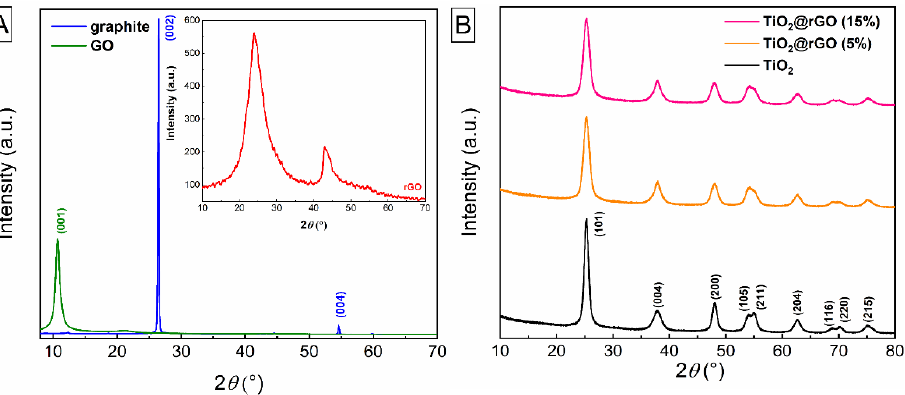
Figure 3 . X-ray diffraction patterns. ( A ) pure graphite and synthesized GO (inset shows rGO); ( B ) TiO 2 and their synthesized nanocomposites.